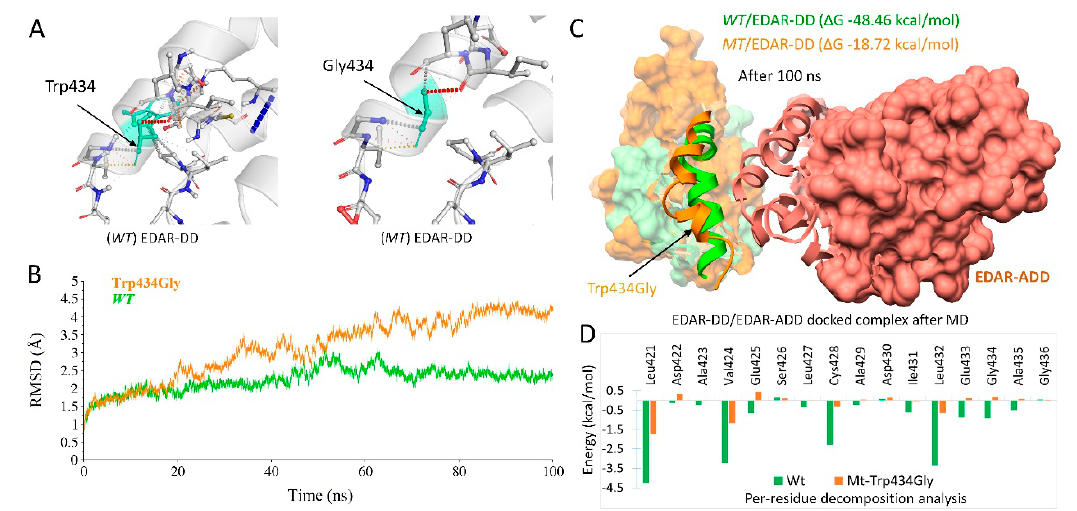
Figure 4. Structural analysis of EDAR complexed with EDARADD. ( A ) Interatomic interactions with a substitution of Trp to Gly at position 434 in EDAR. ( B ) RMSD trajectories of C α -backbone atoms of mutant (brown) and wild-type (green) throughout 100ns. ( C ) Docked conformation of EDAR / EDARADD complex after 100 ns MD simulation, with exposed ribbon conformation of 5 th